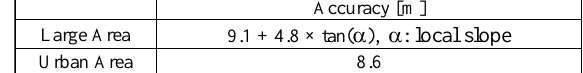
Figure 9. DSM in industrial area on Google Earth